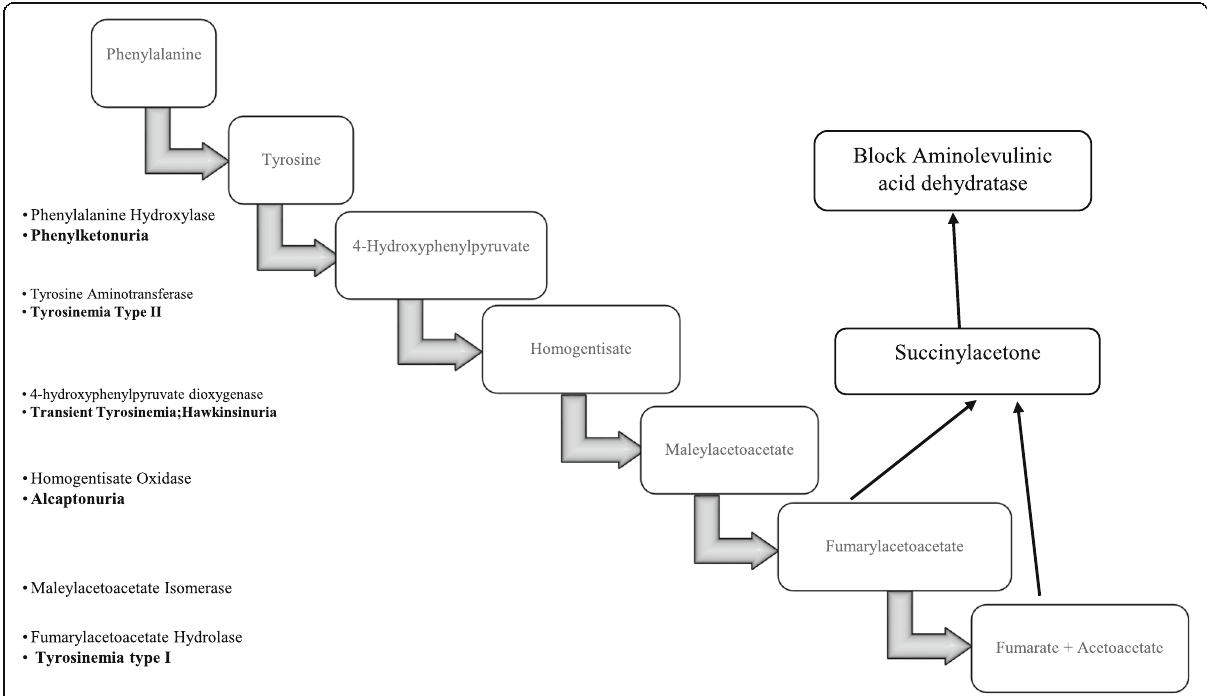
Fig. 3 Pathophysiology of phenylalanine